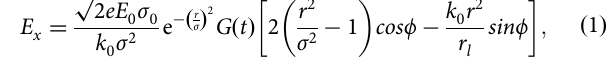
peak value of the laser electric fi eld, α is the direction angle of electric fi eld in the y − z plane, σ 0 is the focal spot radius, σ is the spot radius related to x coordinates, G ( ϕ ) is the temporal shape of